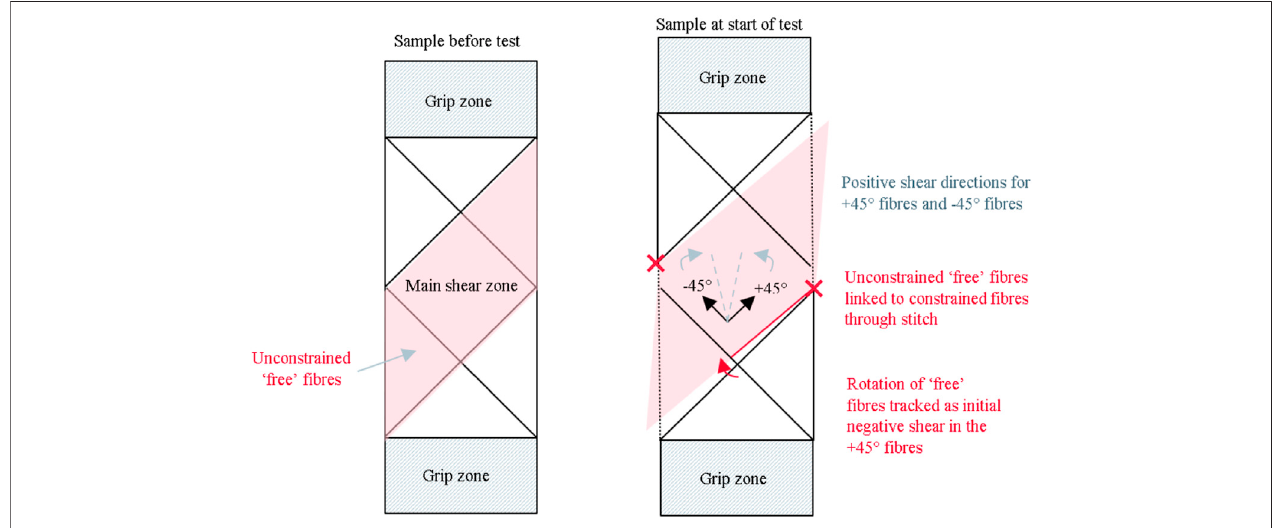
FIGURE 7 | Schematic showing initial negative shear behaviour of fabric